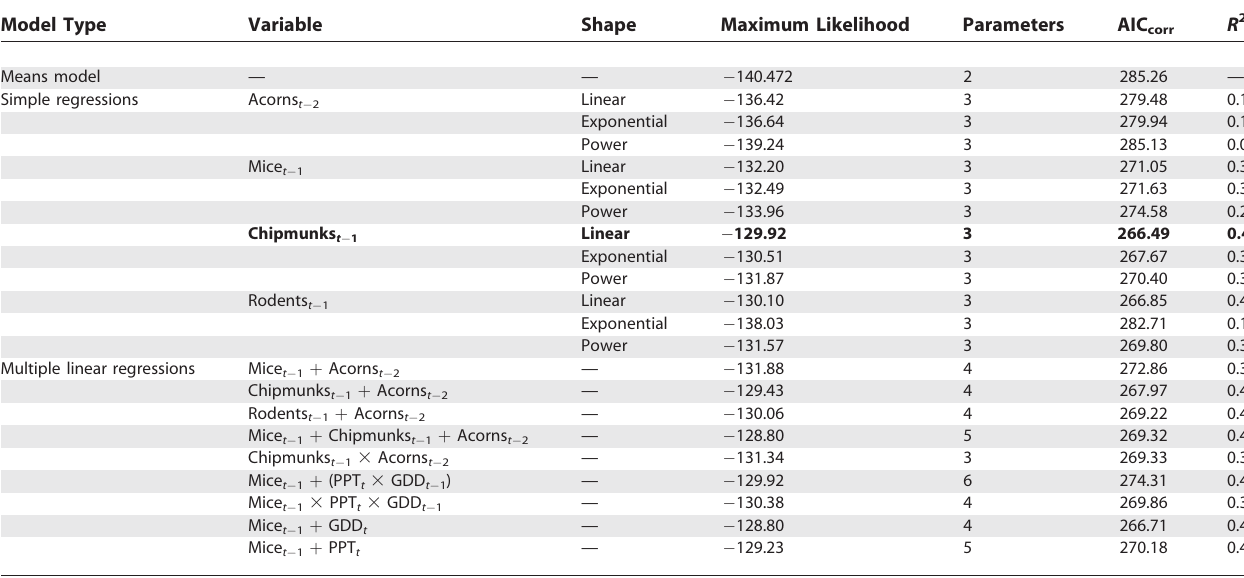
Table 2. Model Comparison Statistics for Independent Variables Potentially Influencing the DON Based on the Subset of Plot Years for Which All Independent Variables Were Estimated (42 Plot Years) Model Type Variable Shape Maximum Likelihood Parameters